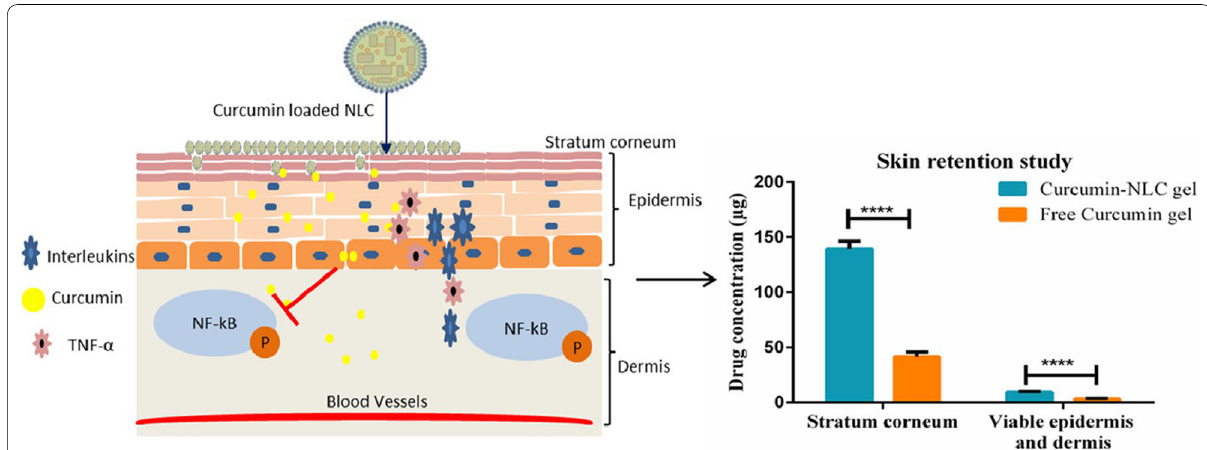
Fig. 3 Formulation of Curcumin based NLCs for skin cancer. Reproduced with permission from Rapalli et al.